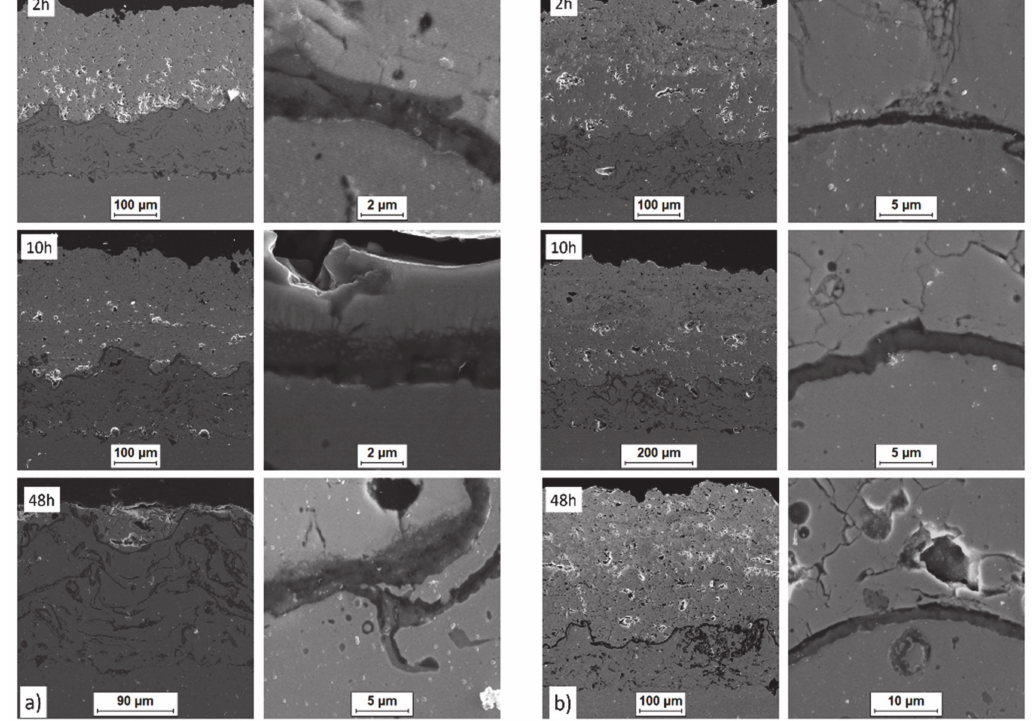
Figure 26. Crack nucleation and growth in the ceramic top layer and, phenomena during TGO zone formation as a function of time of oxidation: ( a ) monolayered La 2 Zr 2 O 7 and ( b ) DCL La 2 Zr 2 O 7 / 50% La 2 Zr 2 O 7 + 50% 8YSZ / 8YSZ.